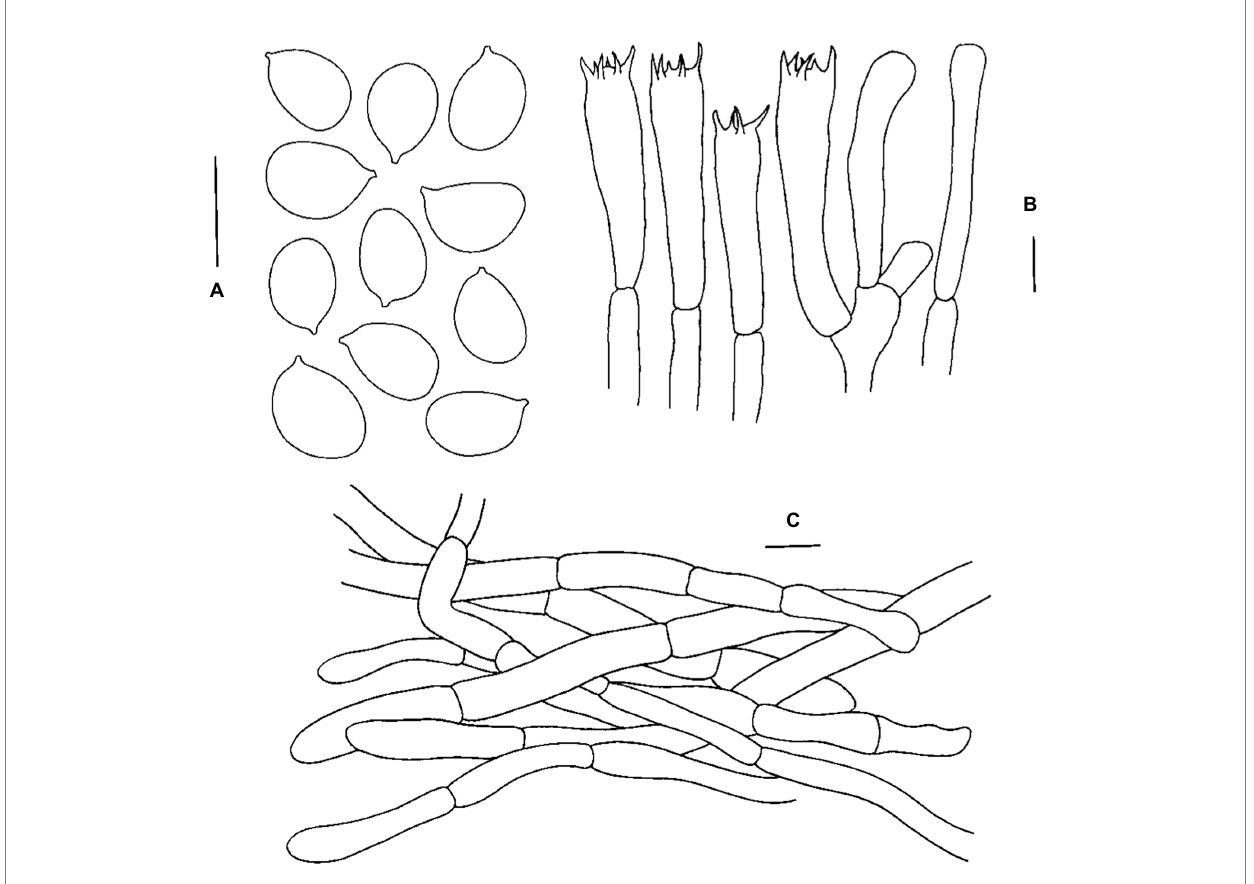
FIGURE 4 Microscopic features of Cantharellus cineraceus (FHMU968, holotype). (A) Basidiospores. (B) Basidia. (C) Pileipellis. Scale bars = 10 μ m. Drawings by Y. Z.